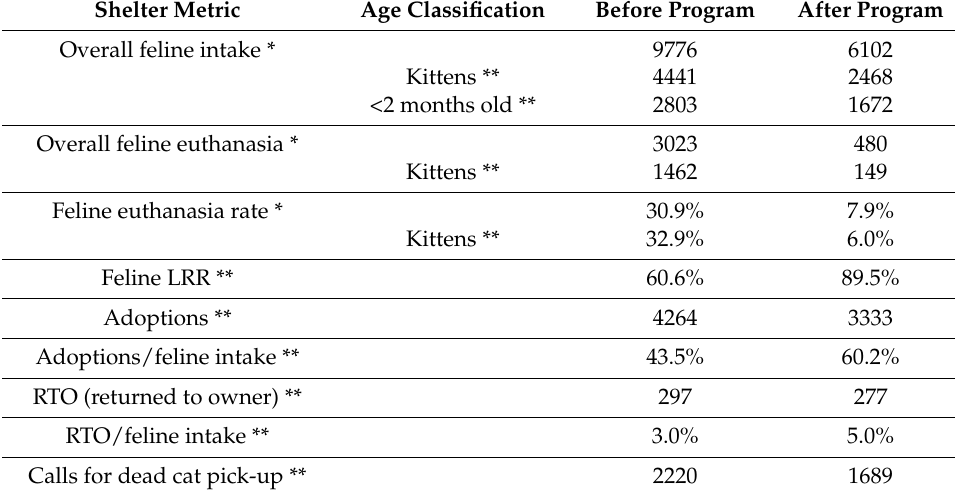
Table 2. Common shelter metrics before and after implementation of Albuquerque’s